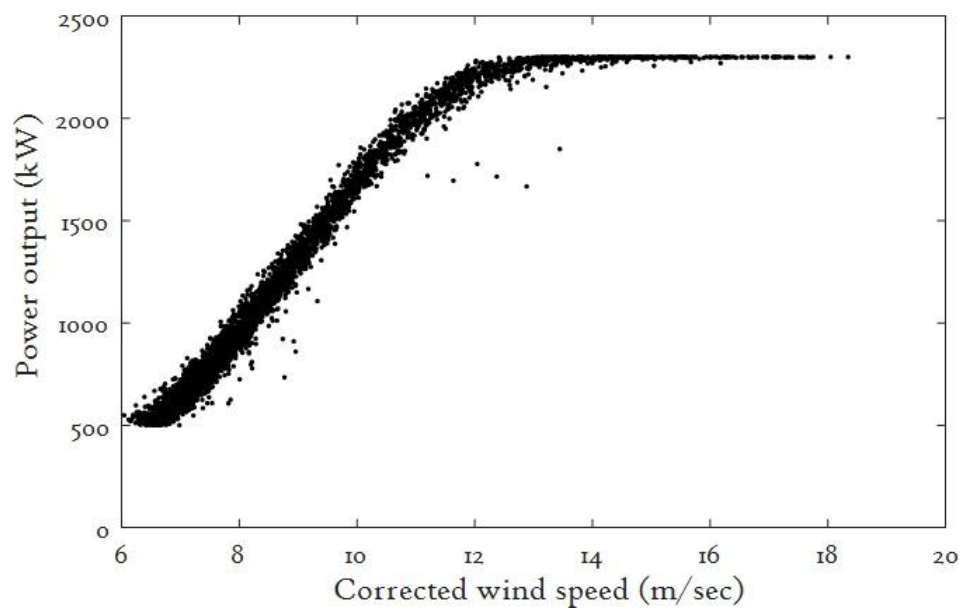
Figure 2. Raw power curve data .